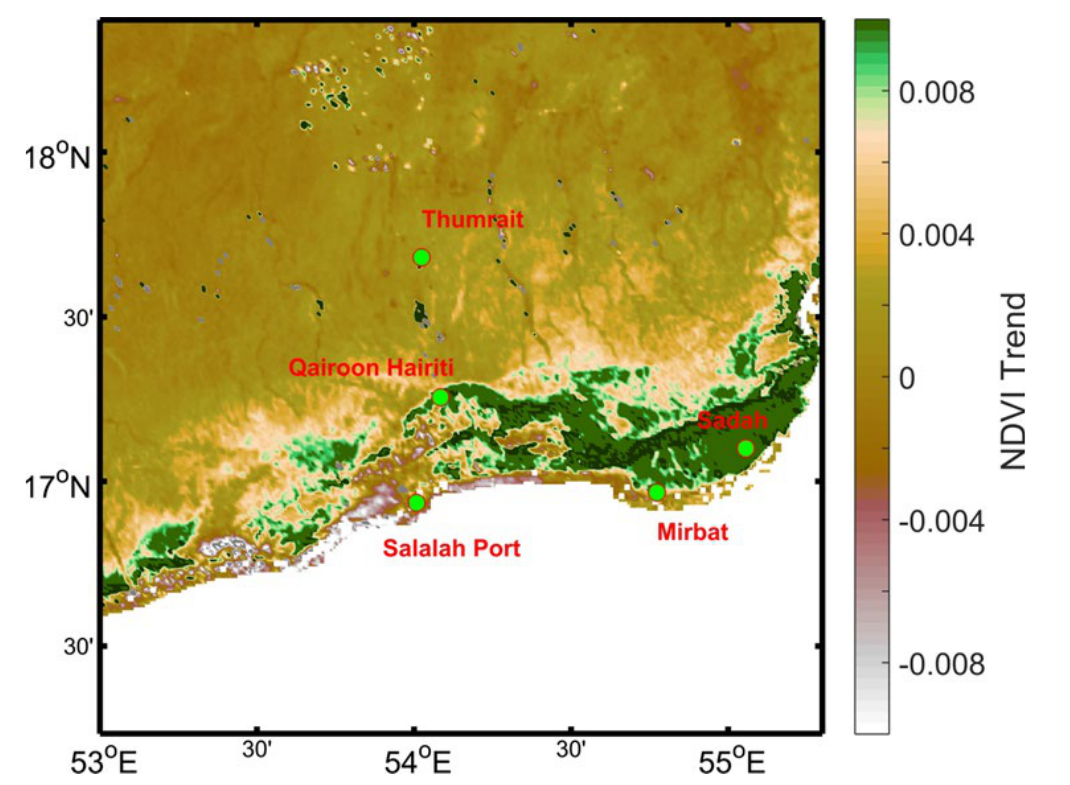
Figure 7. NDVI trends in the study area during the period 2015–2020. Data obtained from the Proba-V satellite.